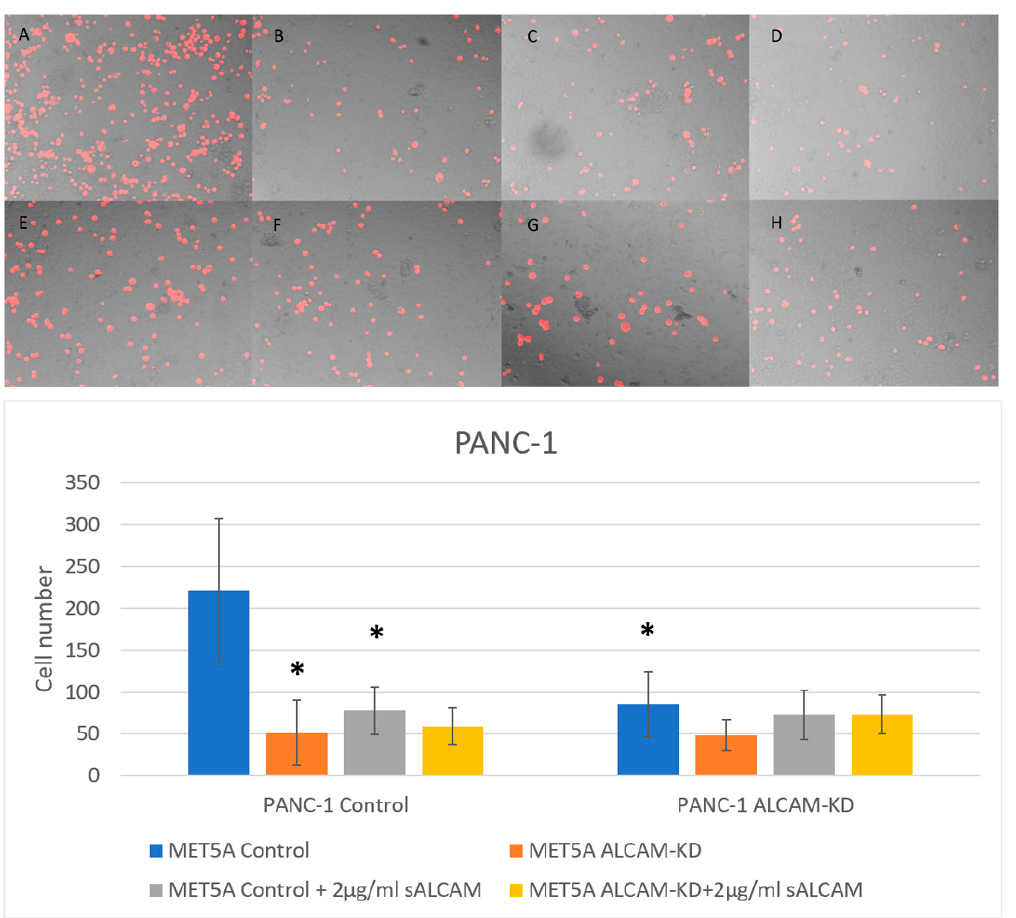
Figure 7. Interaction between pancreatic cancer cell line PANC-1 and mesothelial cell line MET5A as determined by the DiI based assays. ( Top ): Representative images (×10 magnification) of pancreatic cancer cells (PANC-1 Control and ALCAM knockdown cells) adherence to mesothelial cells (MET5A Control and ALCAM knockdown cells). ( A – D ) represent wells without any treatment and E-H represent wells treated with 2 µg/mL sALCAM. ( A , E ): MET5A Control + PANC-1 Control; ( B , F ): MET5A Control + PANC-1 ALCAM knockdown; ( C , G ): MET5A ALCAM knockdown + PANC-1 Control; ( D , H ): MET5A ALCAM knockdown + PANC-1 ALCAM knockdown. ( Bottom ): Graphical representation of pancreatic cancer cells (PANC-1 Control and ALCAM knockdown cells) adherence to mesothelial cells (MET5A Control and ALCAM knockdown cells). * Groups which showed significantly differences compared with “MET5A Control + PANC-1 Control” group ( p < 0.05).